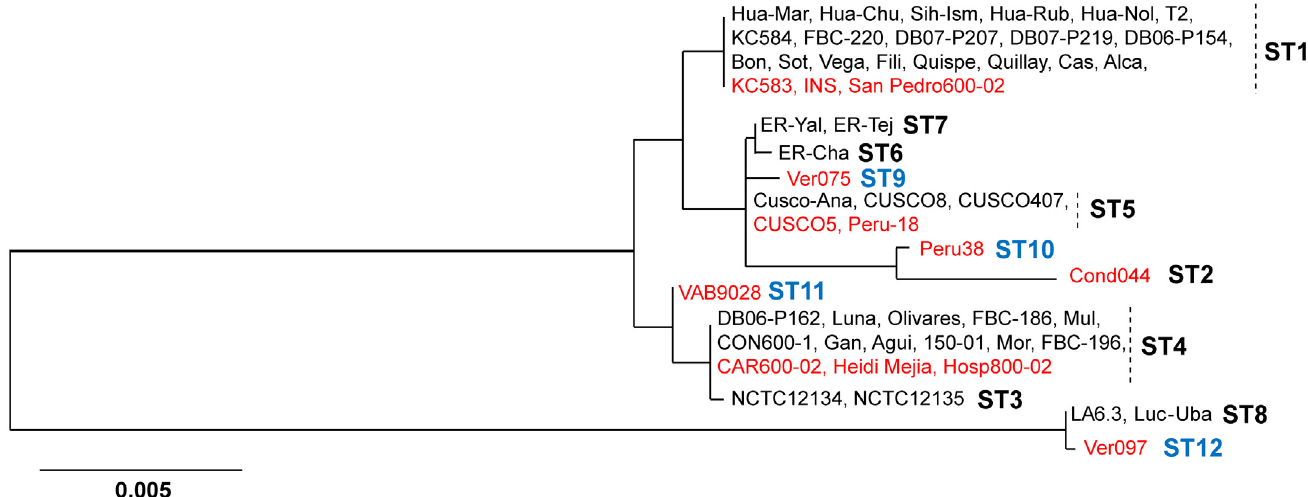
Fig 1. Phylogenetic reconstruction of B . bacilliformis . The tree was based on concatenated internal fragments of seven MLST loci ( bvrR , flaA , ftsZ , groEL , ribC , rnpB and rpoB ) from 13 completely sequenced strains (shown in red) and 43 strains analyzed in earlier work [17] (including three completely sequenced strains: KC583, CUCSO5 and